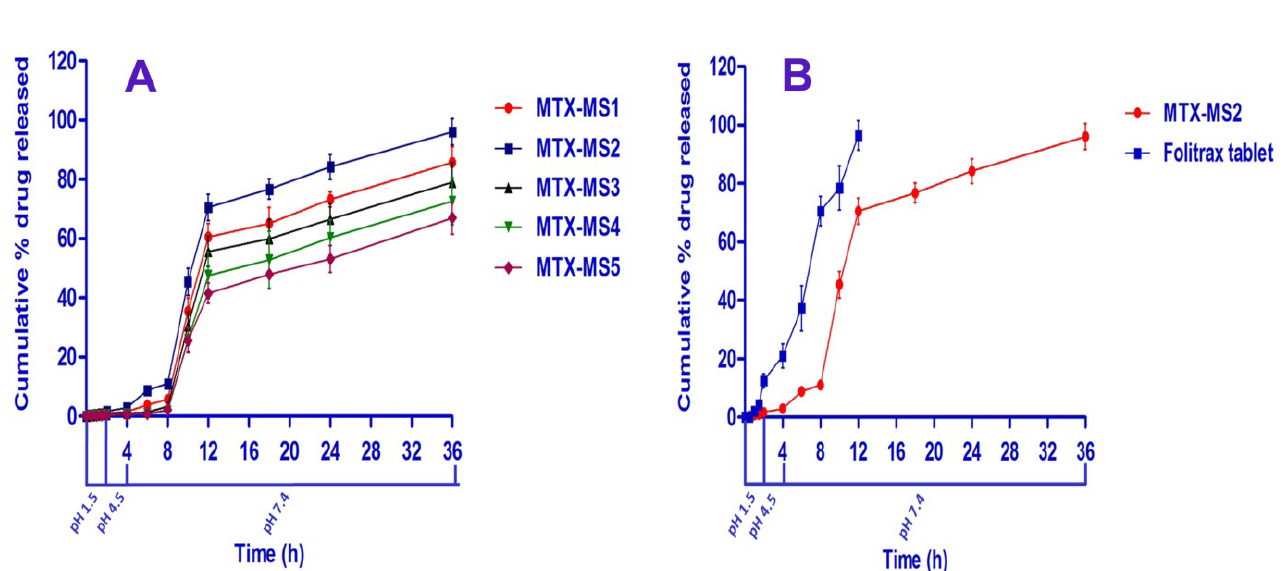
FIGURE 3 – In vitro drug release profile of methotrexate loaded mucoadhesive microparticles, MTX-MS1-5 (A) and optimized microparticles, MTX-MS2 and Folitrax (B) at pH 1.5, 4.5 and 7.4. The values were mean ± SD (n = 3).